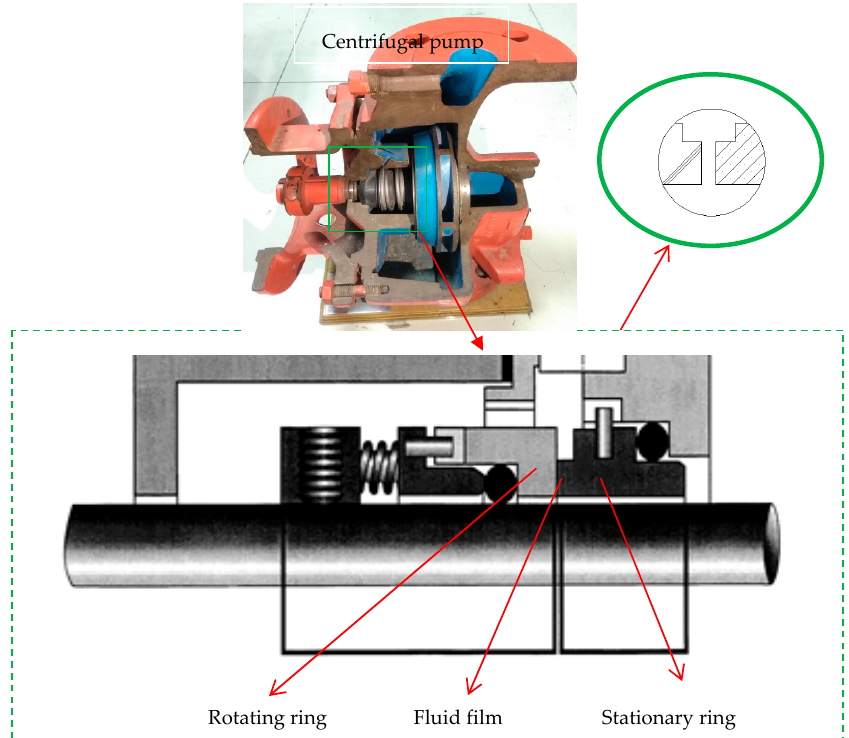
Figure 1. Schemes of mechanical seal model.